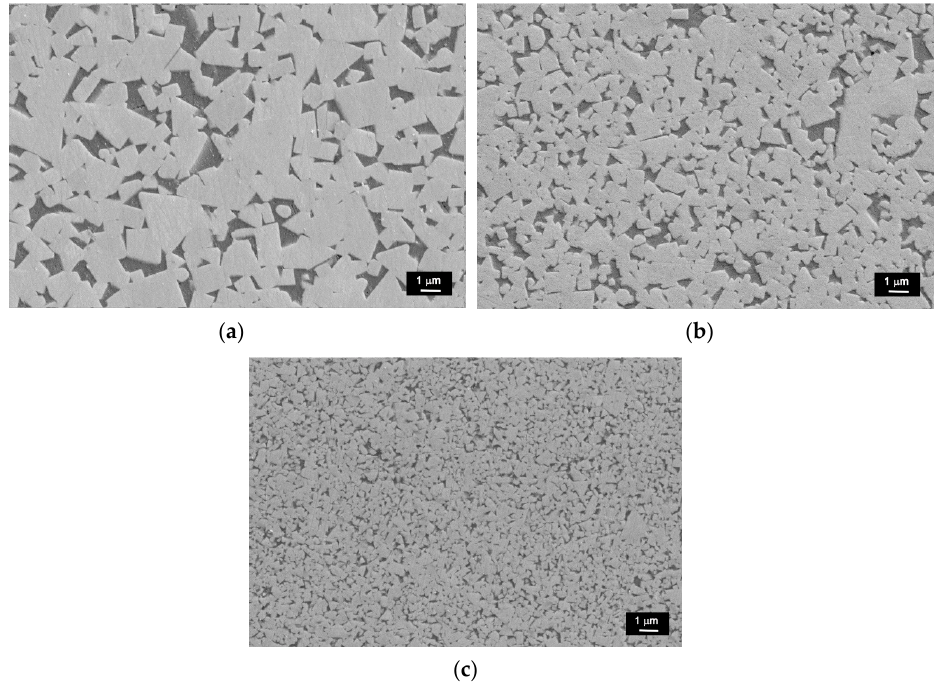
Figure 5. Microstructure of the bulk ( a ) 12CoM, ( b ) 12CoF and ( c ) 12CoUF